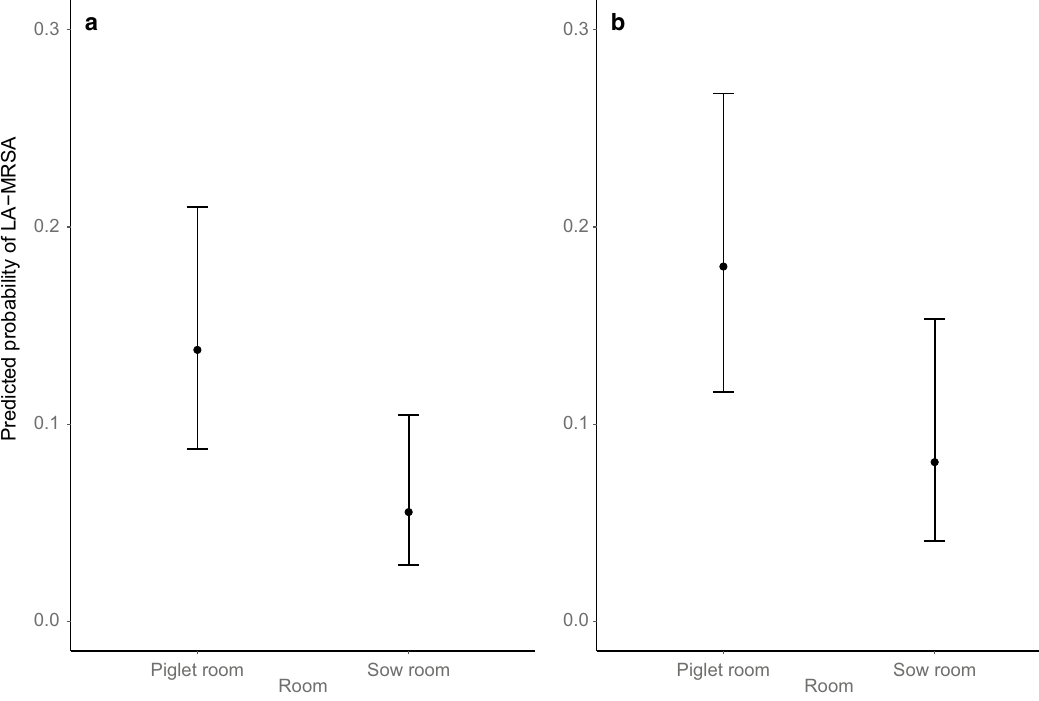
Figure 3. Predicted LA-MRSA prevalence with confidence intervals (95%) between the samples from the piglet room and sow room calculated by the generalized linear mixed-effects logistic model for both caged cultivated house flies ( a ) and calculated by the regular generalized linear model for wild free-roaming flies ( b ). Both the wild free-roaming flies and caged cultivated house flies from the piglet room tested positive for LA-MRSA in significantly greater proportions than the wild free-roaming flies and caged cultivated house flies from the sow room.